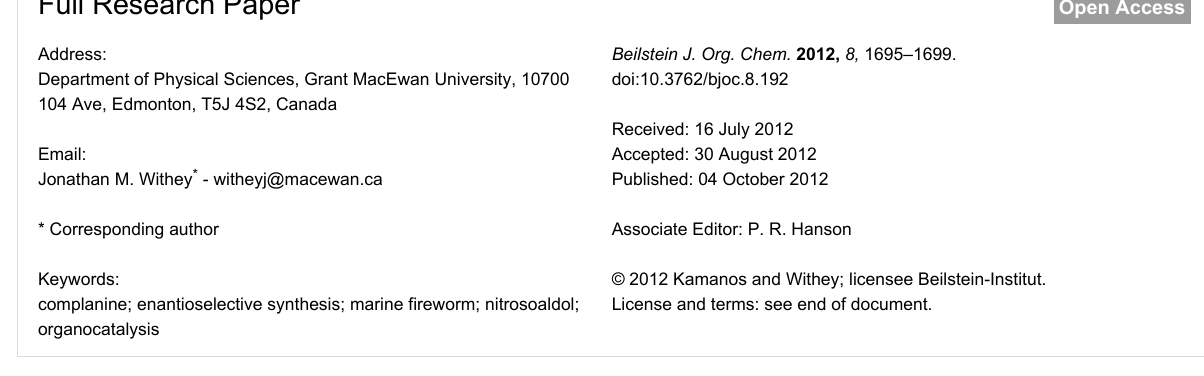
alcohol N -acylated with a γ -aminobutyric acid (GABA) deriva- tive. Complanine is structurally related to the obscuraminols, isolated from another marine source, the ascidian Pseudodis- toma obscurum [2]. Unlike complanine, however, these substances are simple amino alcohols that do not possess any other chemical functionalities. Synthetic studies, also conducted by Nakamura and Uemura, established the absolute structure and configuration as ( R )-( − )-complanine (Figure 1), showing it to be related to other natural products that possess the